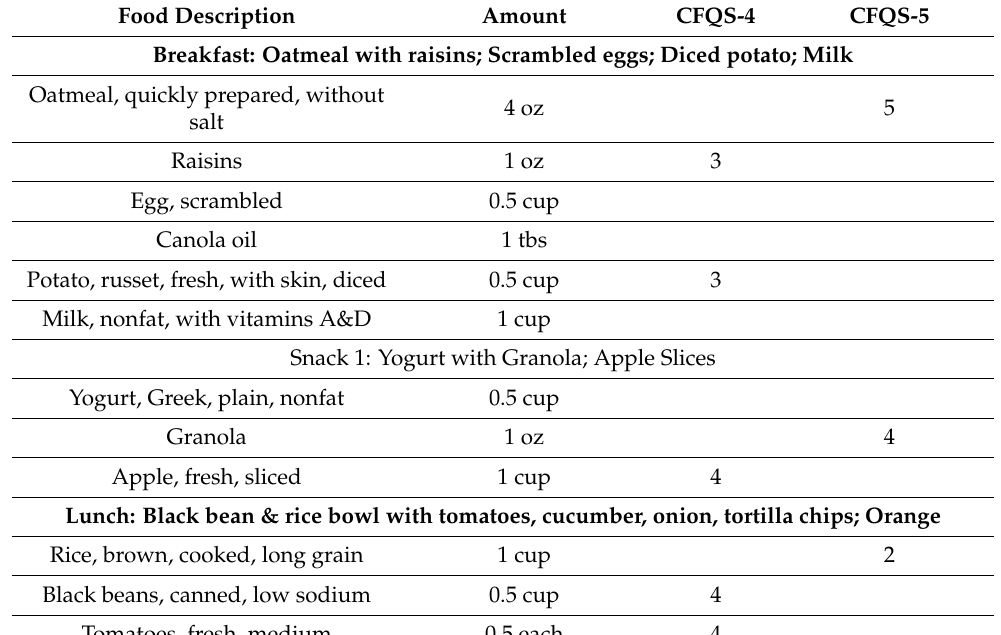
Table 6. Sample Daily Menu: Healthy